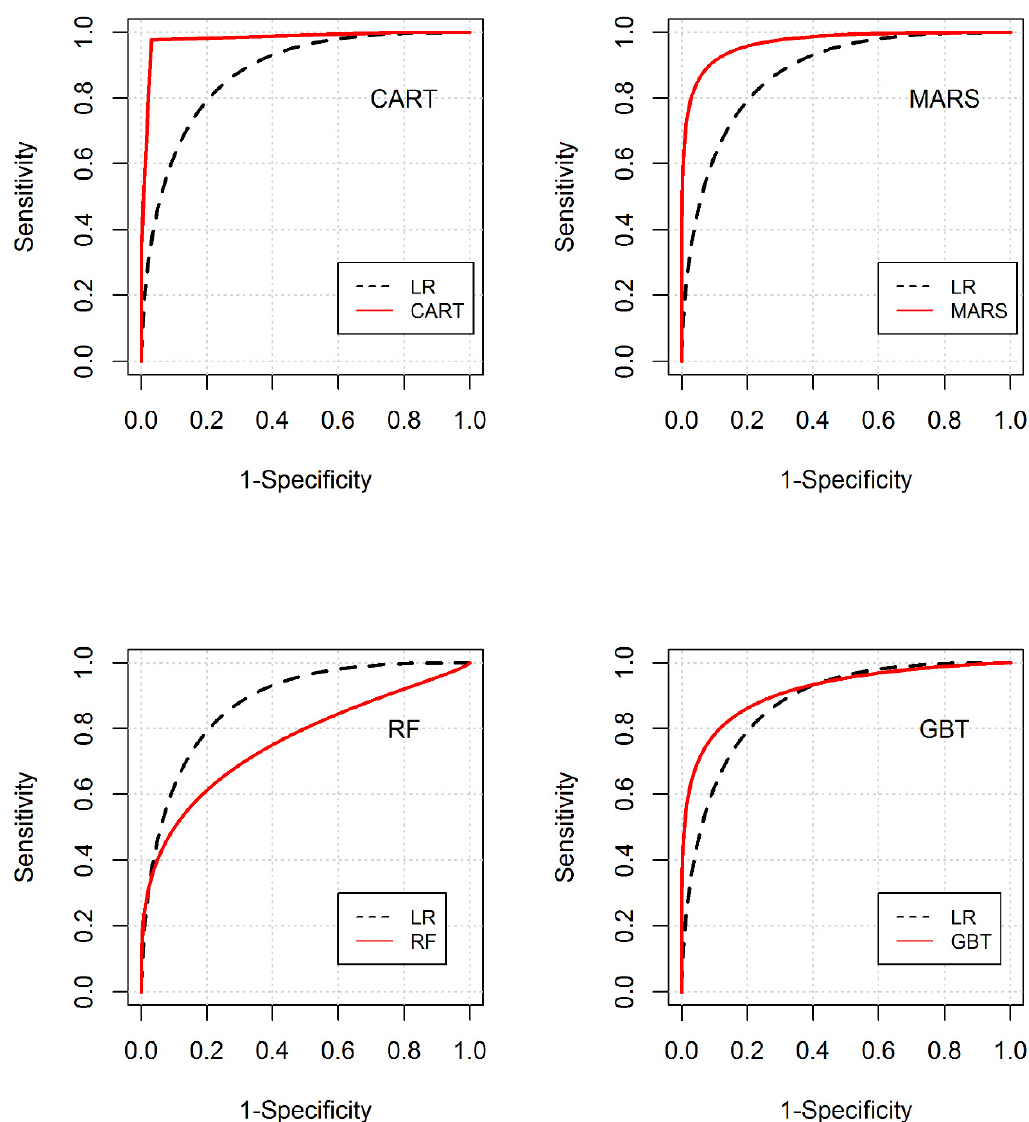
Figure 8. Comparison of Receiver Operating Characteristics (ROC) of Tree-Based and LR Model Classification for the Training Dataset.